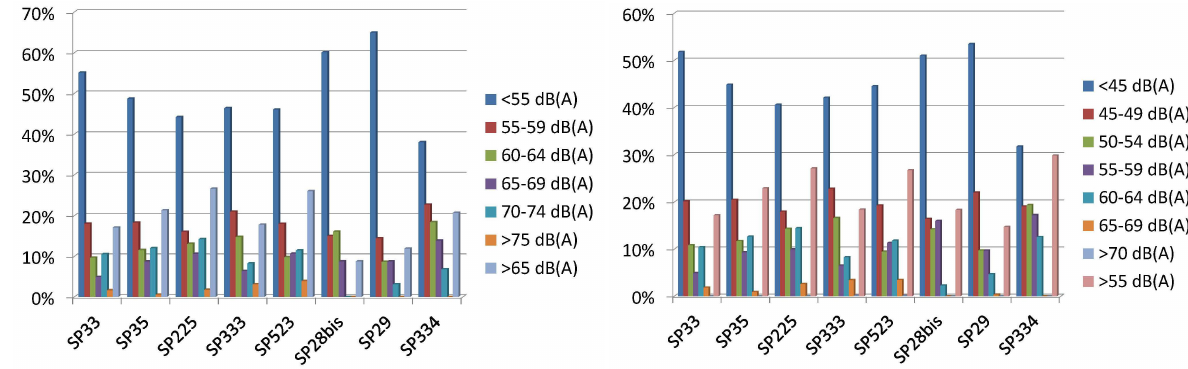
Figure 4: Percentage of population exposed to noise emitted by roads analysed in terms of L den (left) and L n (right)